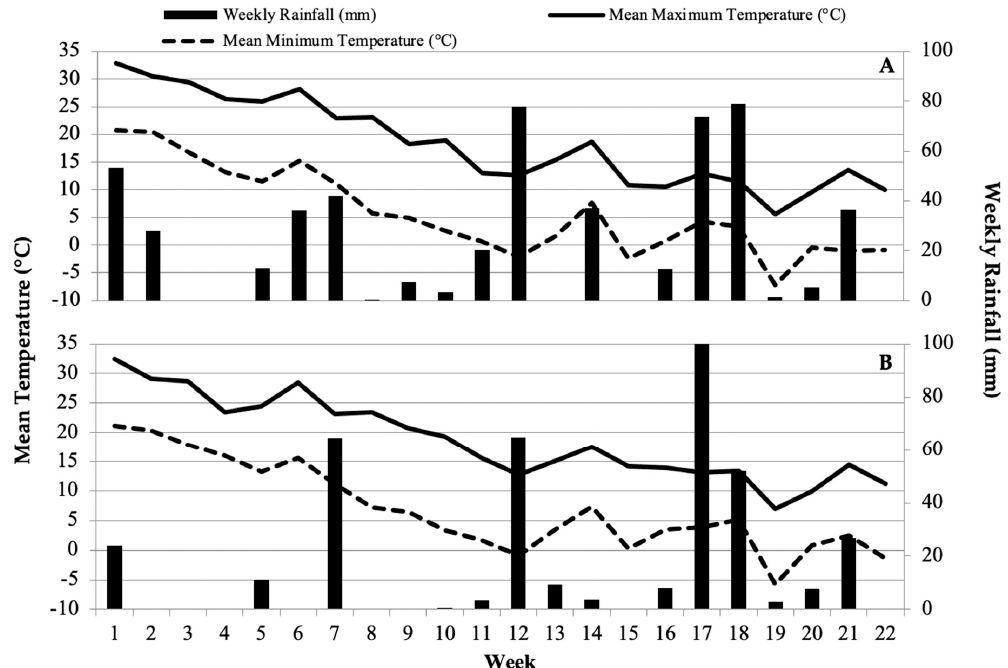
Figure 1. Mean maximum and minimum temperature for the Calhoun, GA ( A ) and Watkinsville, GA ( B ) 2014-15 growing season of the canola trial. Week 1 corresponds to the week of the 1 September (S1) planting date and week 22 corresponds to the end of January of each year.